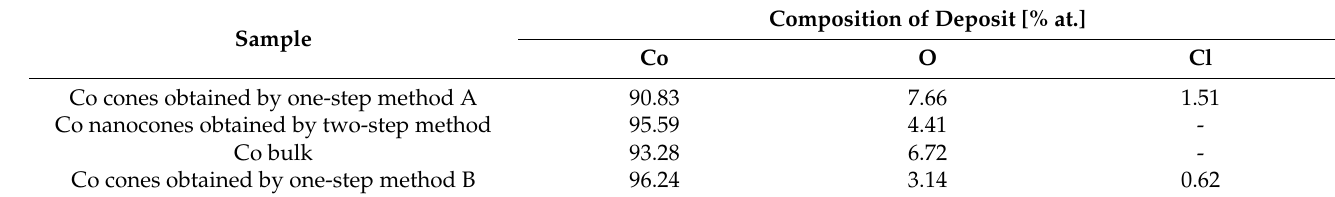
Table 2. Comparison of deposit compositions.